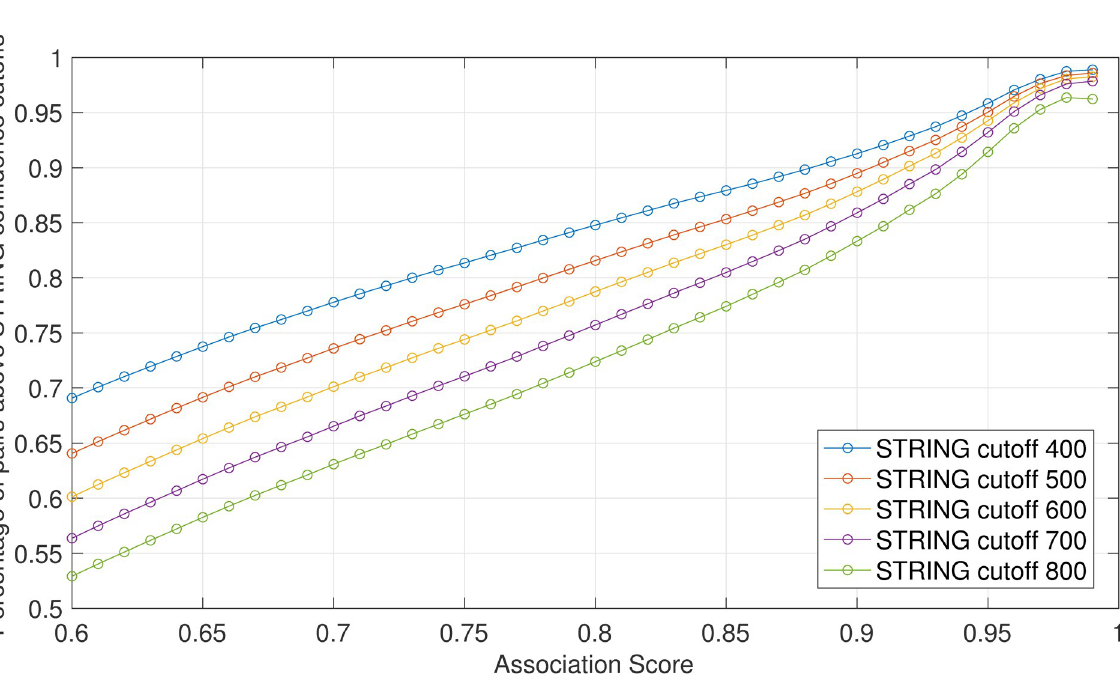
PLOS Computational Biology | https://doi.org/10.1371/journal.pcbi.1009497 April 11,